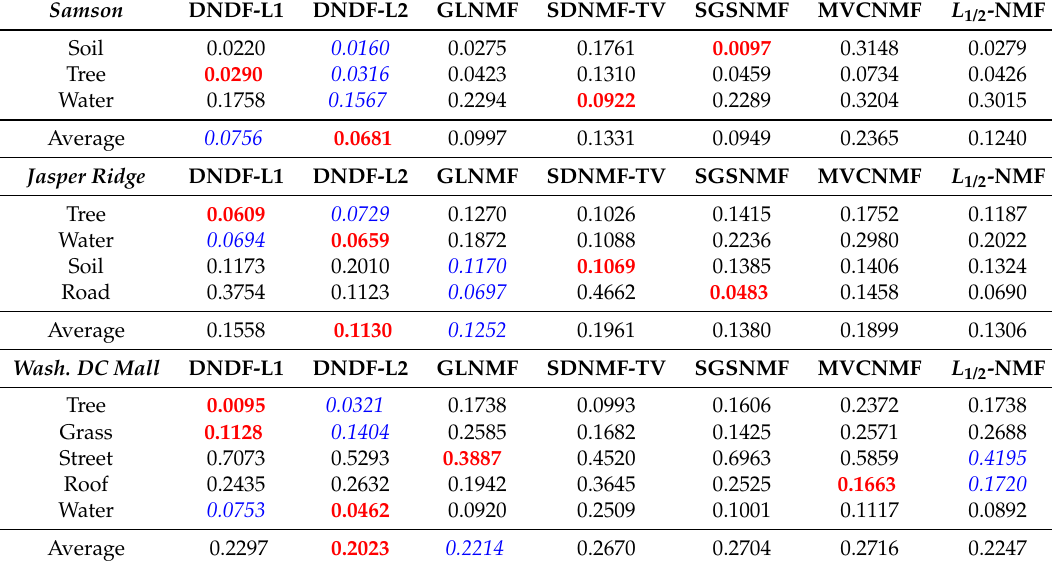
Table 2. Performance comparison w.r.t the metric of spectral angle distance (SAD) on three datasets (in radians), where a smaller SAD value indicates better performance signifying the better similarity between the estimated endmember and the reference one. Red bold and blue italic denote the best and second-best results,